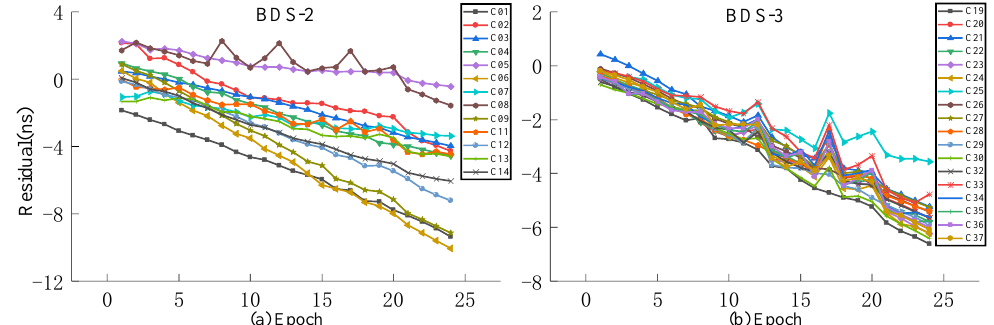
Figure 13. The residual plot of the ISUP model using the 6th hour update ultra-fast clock product of the day. ( a ) The residual value of BDS-2 predicted after 6 h. ( b ) The residual value of BDS-3 predicted after 6 h.